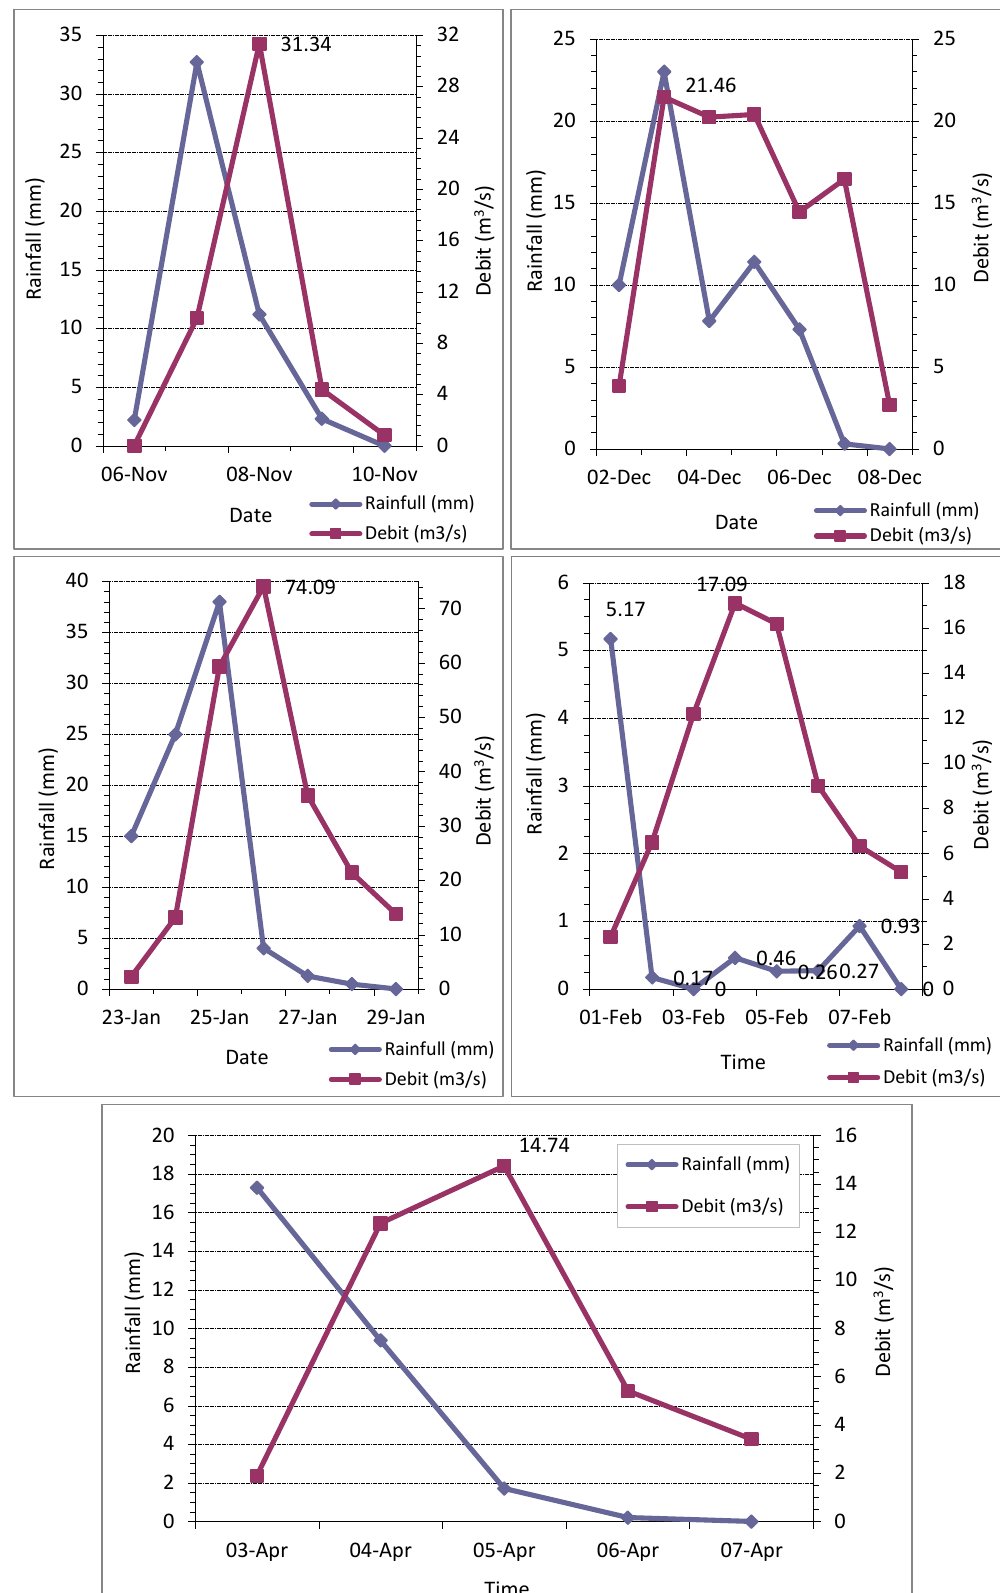
Figure 32. Average daily rain-flow couple during the exceptional year 2002/2003 Relation of the Actual Flow Entering the Bowl and Contribution of the Hydrometric Station To obtain a relation which connects the flows recorded at the hydrometric station and the flows entering the basin of the dam taken from the hydraulic balance, we have represented on Figure 33 the variation of the Q entering the basin according to Q recorded at the hydrometric